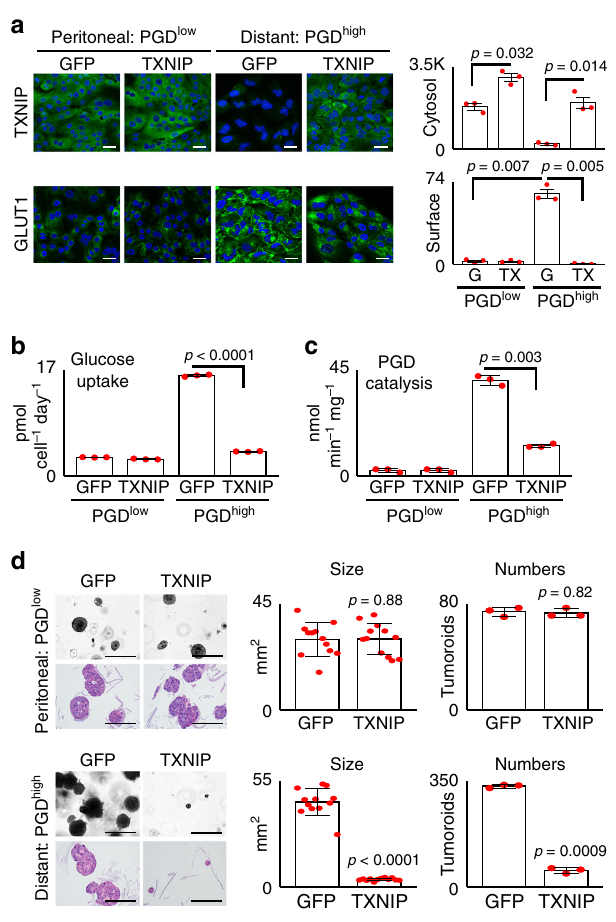
Fig. 3 Exogenous TXNIP phenocopies PGD inactivation. a Expression of exogenous TXNIP (top panels) in the PGD high distant metastasis (38Lg) to levels comparable with baseline TXNIP expression in control PGD low peritoneal deposit (38Per) removed GLUT1 from the cell surface in PGD high cells (bottom panels) ( n = 3 biological replicates; error bars: s.e.m., indicated p values calculated by two-tailed t tests; G: GFP; TX: TXNIP). Scale bars: 20 µ m. b Exogenous TXNIP slowed glucose consumption in the PGD high cells down to rates comparable with matched PGD low controls ( n = 3 technical replicates, error bars: s.d.m., p <0.0001 by two-tailed t tests). c Exogenous TXNIP also slowed PGD catalytic rates in PGD high cells ( y -axis: NADPH production rates; n = 3 technical replicates, error bars: s.d.m., p = 0.003 by two-tailed t tests). d Exogenous TXNIP strongly impaired 3D tumoroid growth of PGD high cells with no effect on control PGD low contro l s ( n = 3 – 12 technical replicates; error bars: s.d.m., indicated p values calculated by two- tailed t tests). Top panels: bright fi eld microscopy of live tumoroids. Bottom panels: H&E stains of fi xed tumoroids. Scale bars: 400 µ